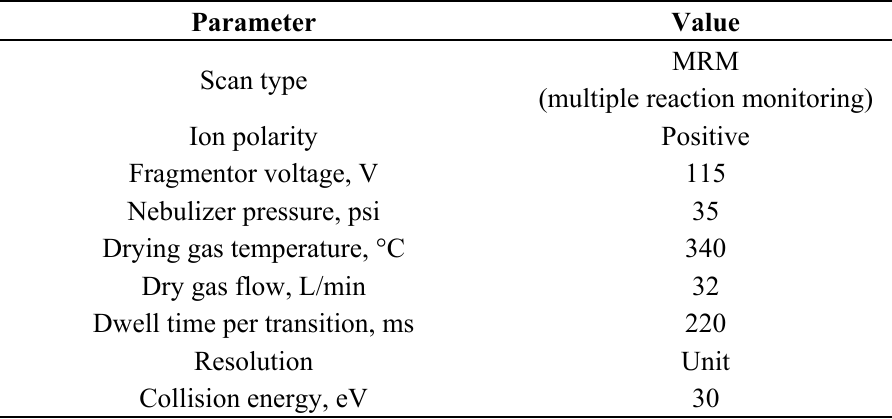
Table 4. Main working parameters for tandem mass